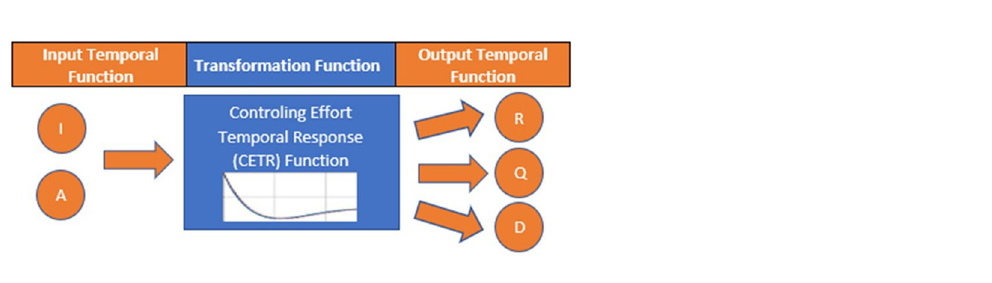
Figure 7. Convolutional prediction model